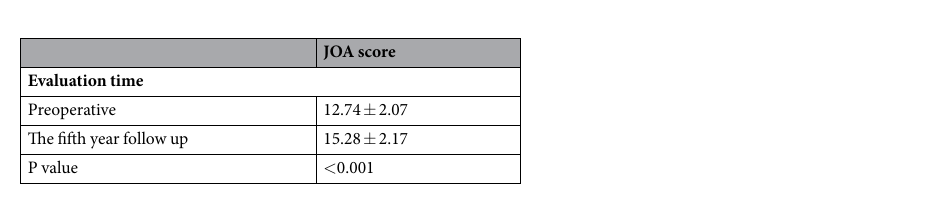
Table 2. preoperative and fifth year follow-up score according to the